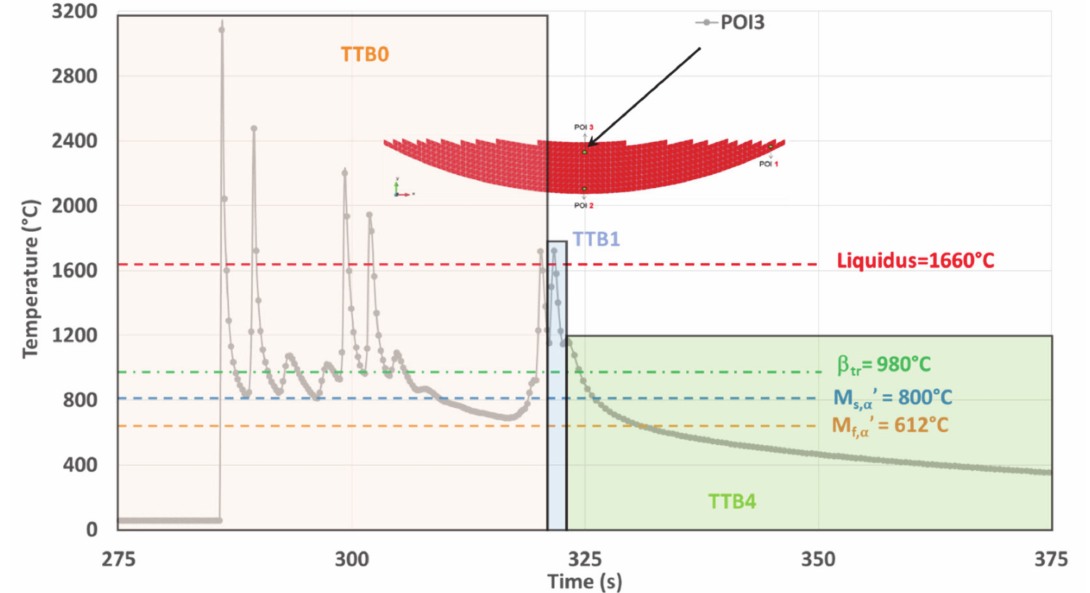
Figure 16. TTBs sequence within the simulated thermal history on POI3 where both TTB2 and TTB3 are missing due to quasi-continuous cooling straight from the last remelting, down to room